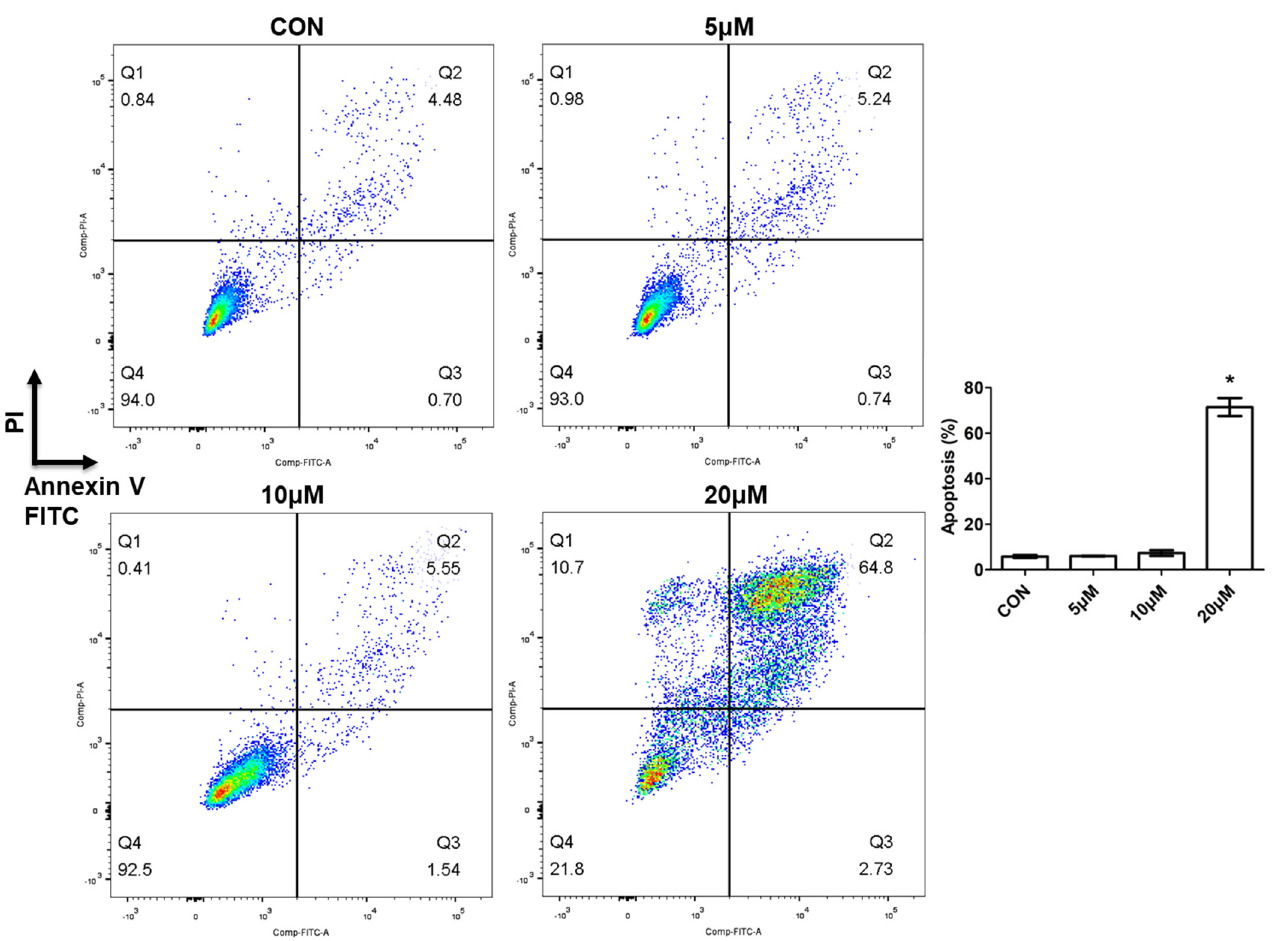
Figure 4. Compound 5d induced cell apoptosis. MCF-7 cells were treated with 5 μ M, 10 μ M, 20 μ M of compound 5d for 48 h, then cells were collected and stained with Annexin-V and PI. Apoptotic cells were determined by flow cytometry. Data were presented as means ± SEM, * p < 0.05.